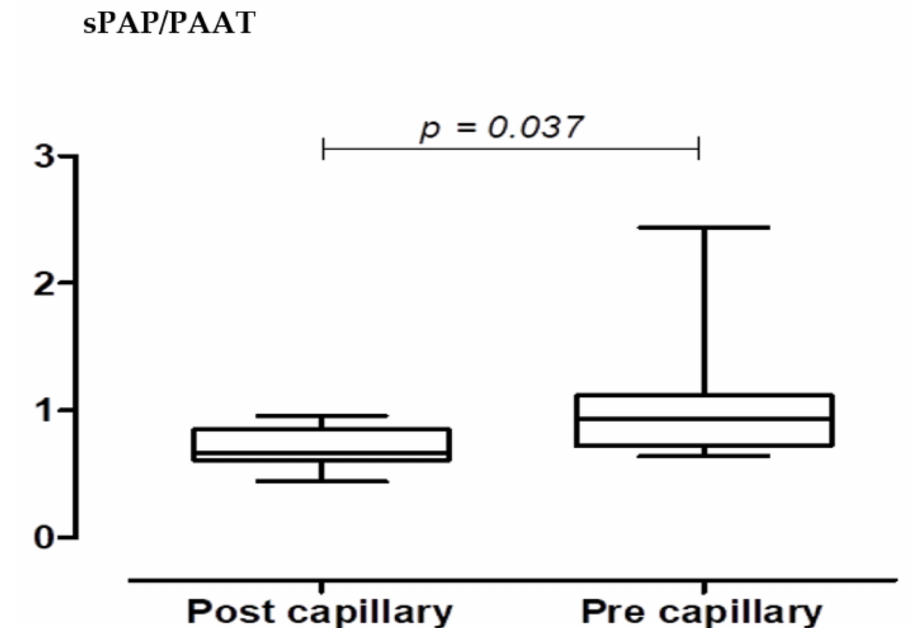
Figure 2. The initial data derived from the analysis of the 20 Ssc patients show that those presenting pre-capillary PH at cardiac catheterization had a sPAP/PAAT ratio >of 0.40 ± 0.05. Patients with post-capillary PH had a sPAP/PAAT >of 0.28 There was a significant correlation between sPAP/PAAT and WD, but not with PVR, perhaps due to this parameter having a greater correlation with cardiac output and arterial ventricle coupling.